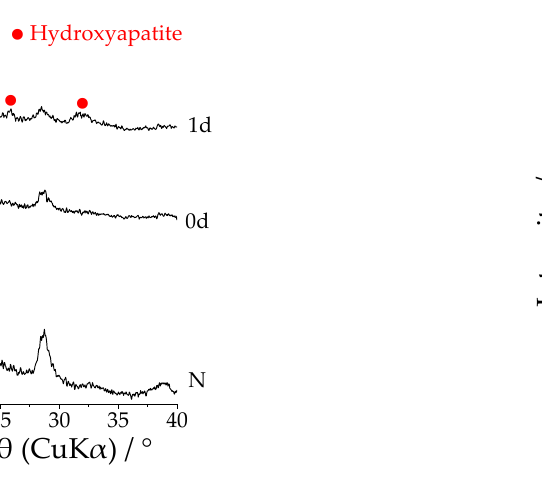
Figure 5. TF-XRD profiles on the surfaces of Samples N: untreated PEEKs (denoted as “N”) and SPA: sulfuric acid + oxygen plasma + modified-SBF-treated PEEKs before (denoted as “0d”) and after immersion in SBF for 1 day (denoted as “1d”) for ( a ) pure PEEK and ( b ) 50C-PEEK.